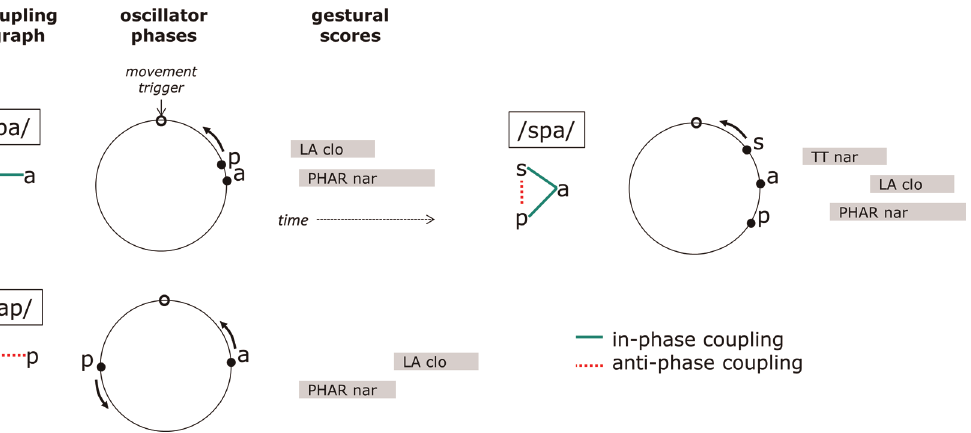
Figure 2. Coupled oscillators model of coordination for CV (/pa/), CCV (/spa/), and VC (/ap/) forms. For each form, a coupling graph is shown with in-phase coupling (solid green lines) and anti-phase coupling (dashed red lines). Oscillator phases proceed counter-clockwise until they reach an arbitrary phase value that triggers movement initiation, i.e. activation of the corresponding gesture in a gestural score.